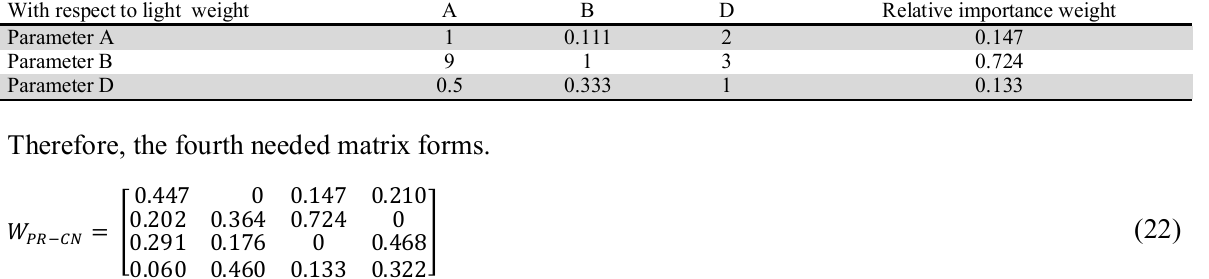
The relations between the PRs with respect to light weight With respect to light weight